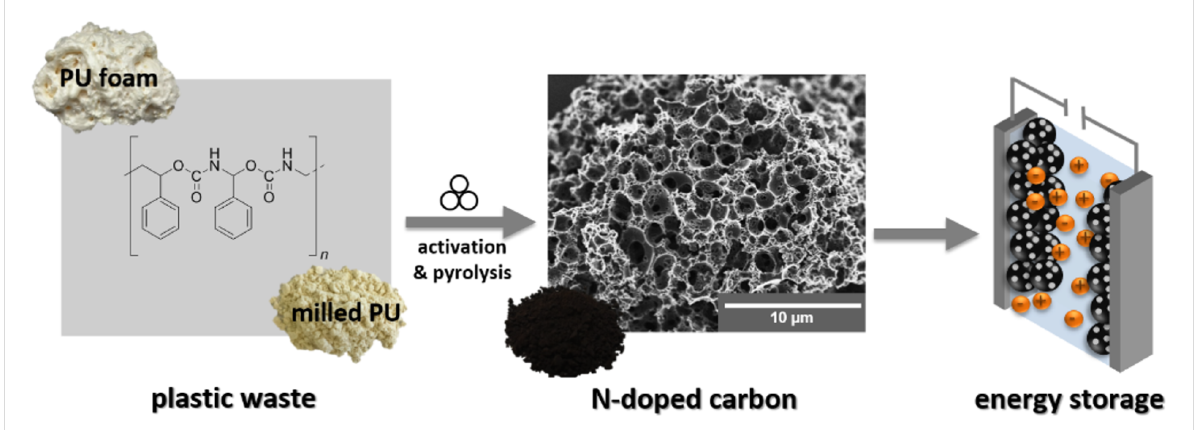
Figure 1: Upcycling approach consisting of high-energy ball milling and carbonization of a mixture of PU foam as the carbon source and potassium carbonate (K 2 CO 3 ) as an activation reagent to form nitrogen-doped porous carbon as an electrode material for